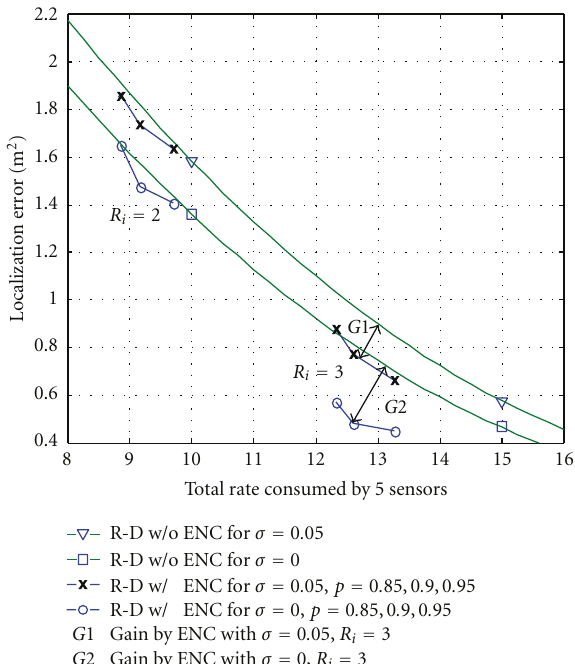
Figure 9: Average localization error versus total rate, R M achieved by the distributed encoding algorithm (global merging algorithm) with R i = 3 and M = 5 . σ = 0,0 . 05 . S Q ( p ) is varied from p = 0 . 85,0 . 9,0 . 95 . Weighted decoding with L = 2 is applied in this experiment.